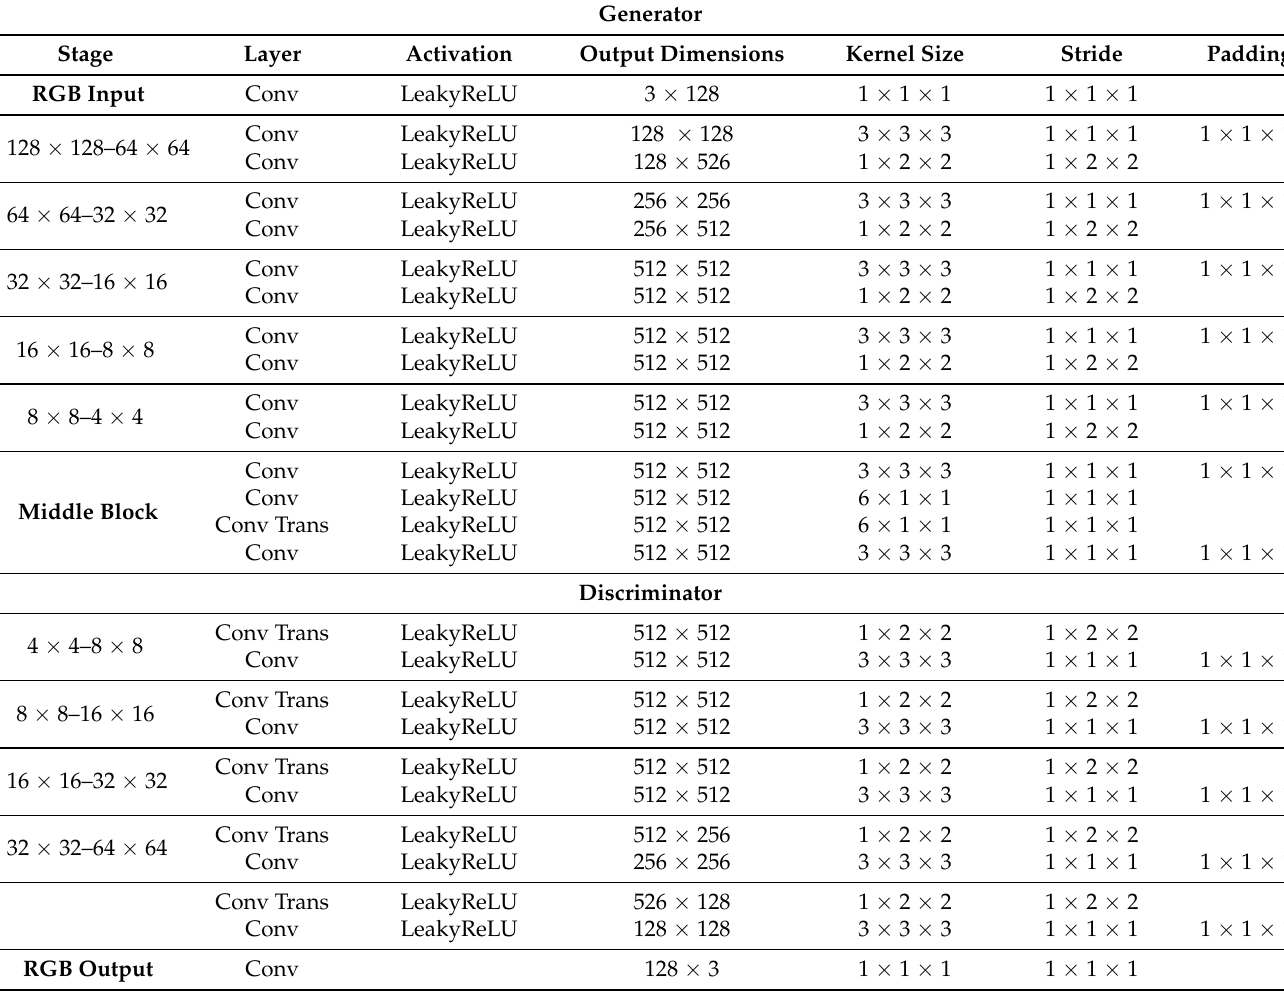
Table 1. The complete GAN architecture; types of layers are described for each resolution stage from input to output. “Conv” refers to layers of equalized convolution, “Conv Trans” refers to transposed convolution layers, and pixelwise normalization is also implemented at every